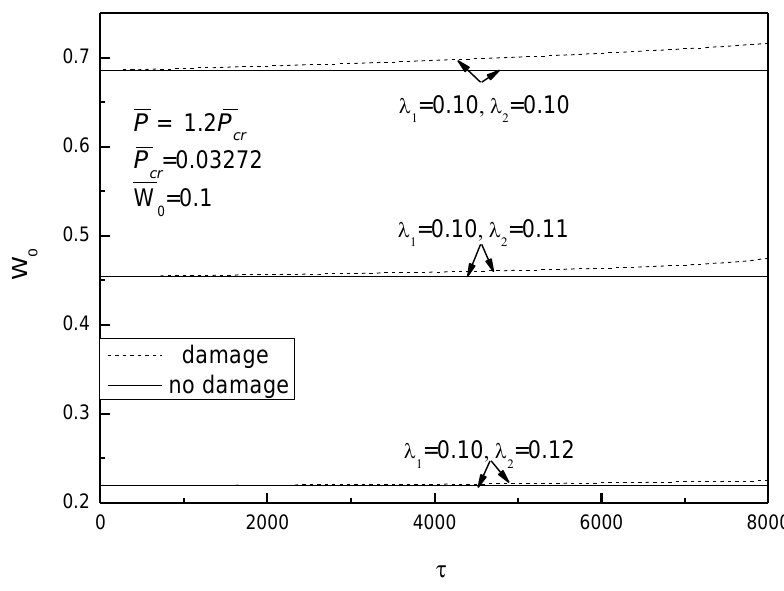
Figure 13. Effect of aspect ratio on postbuckling response curves of piezoelectric plate with damage and initial deflection.